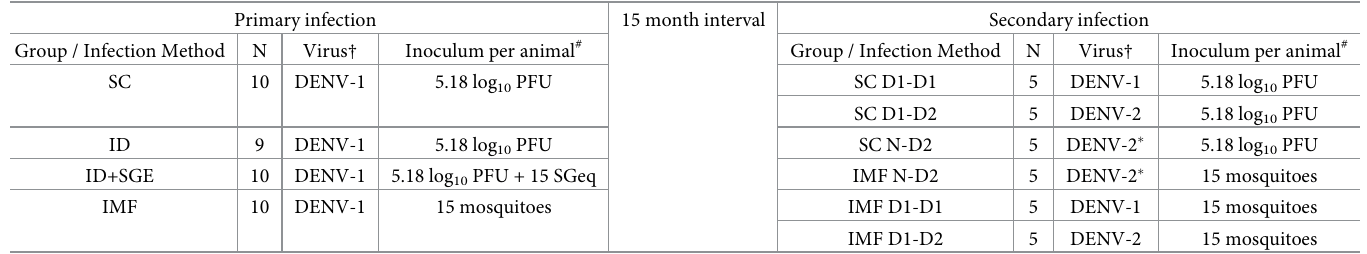
Table 1. Experimental groups and study